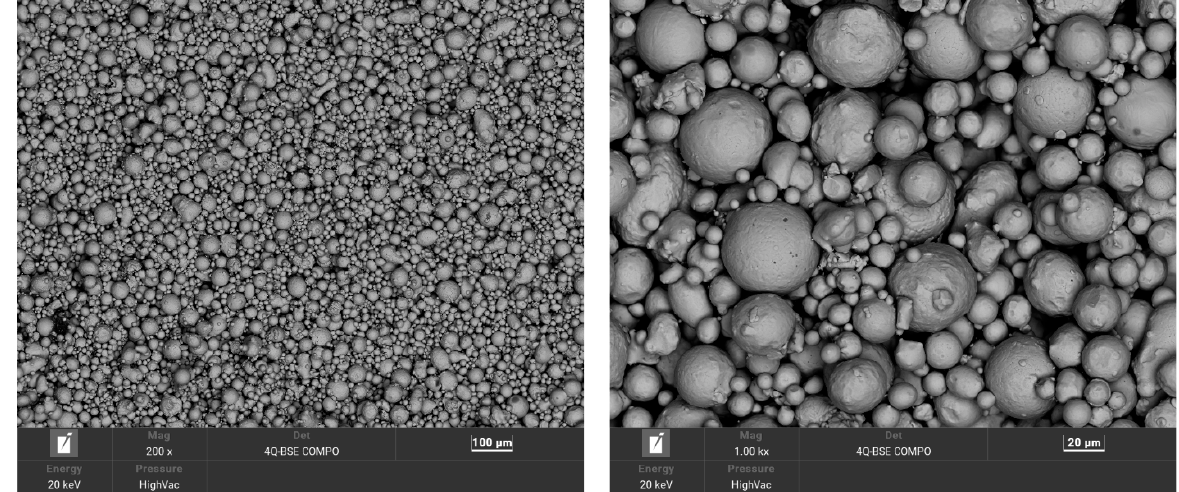
Figure 1. The powder morphology of 1.2709 steel shown at two different image